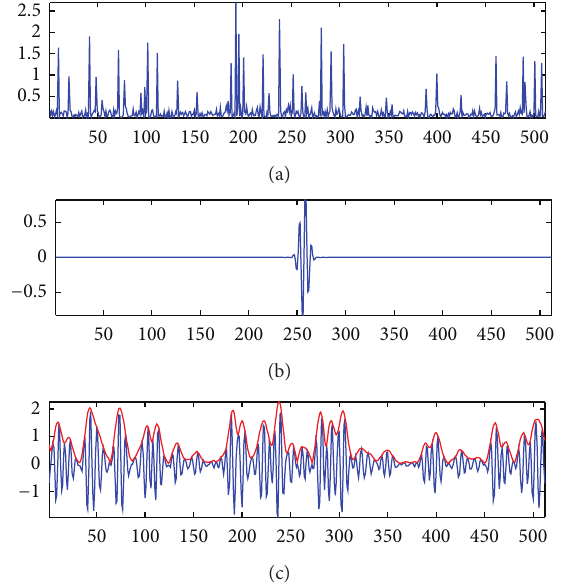
Figure 1: Simulated signals. (a) The generated reflectivity function. (b) The generated PSF. (c) The resulted RF signal and its envelope.